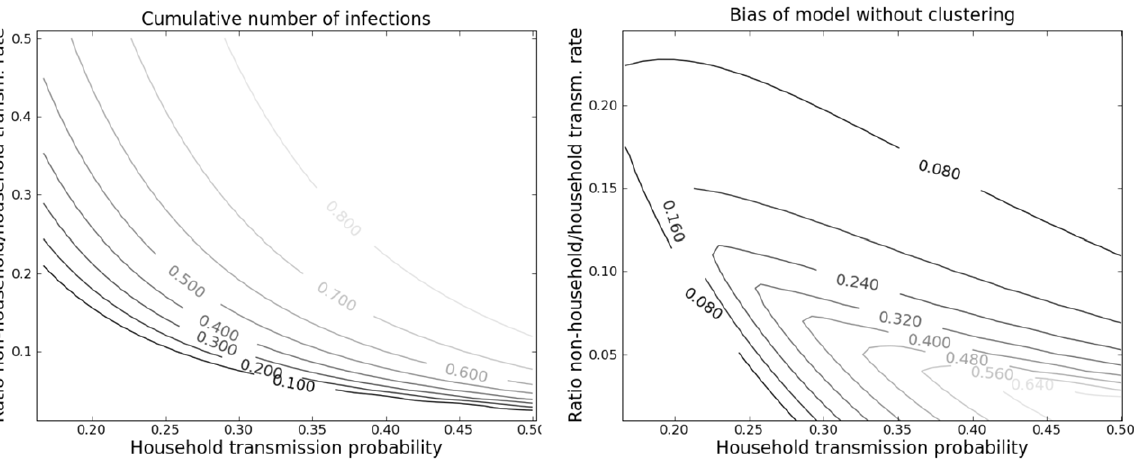
Figure 4. Epidemic size and bias of network models without clustering. Left: The final cumulative number of infections as predicted by the clique model is shown as a function of the transmissibility within households and the transmissibility for contacts outside of households. Right: The difference between final epidemic size in a model without clustering and the final size predicted by the clique model.